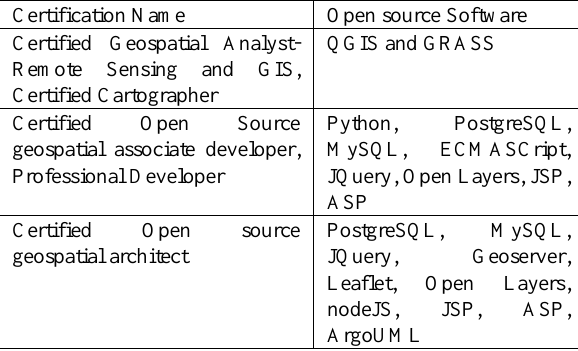
Table 3: Open Source Software